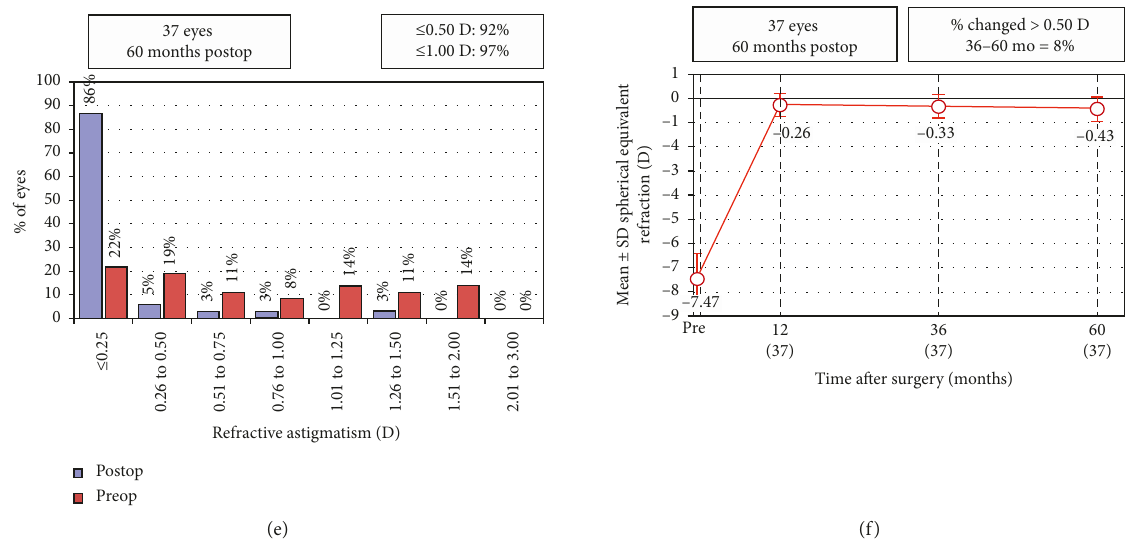
Figure 1: Refractive outcomes at 5 years postoperatively for 37 eyes with high myopia ( ≥ 6D. UDVA: uncorrected distance visual acuity; CDVA: corrected distance visual acuity; D: diopters; Postop: postoperative; Preop: preoperative. (a) Uncorrected distance visual acuity. (b) Change in corrected distance visual acuity. (c) Spherical equivalent attempted vs achieved. (d) Spherical equivalent refractive accuracy. (e) Refractive astigmatism. (f) Stability of spherical equivalent